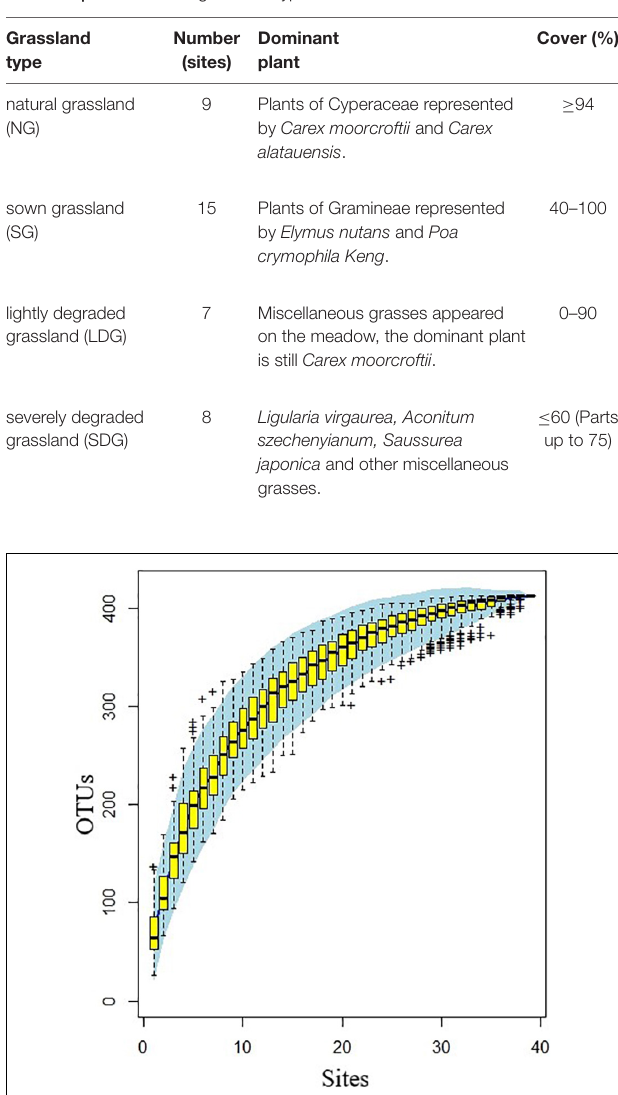
TABLE 1 | Information of sample sites. TABLE 2 | Information of grassland types.